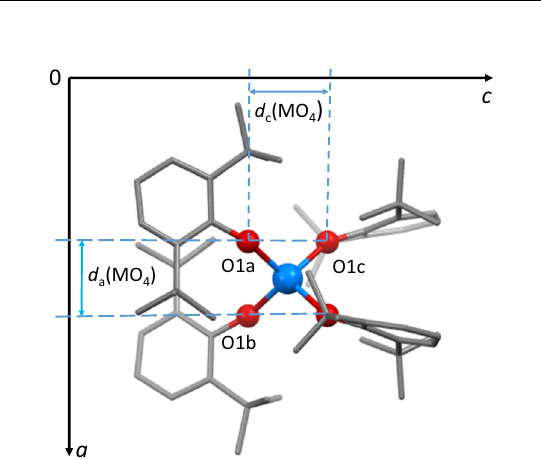
Fig. 2 | The structure of Np(OAr) 4 in the solid state at ambient pressure. Hydrogenatomsandanidenticalmoleculeattheoriginareomittedforclarity.The crystallographicaxesand atomsusedto monitorstructuralchangeswithpressure, and the projections ( d ) along the a and c axes that show the changes in the MO 4 tetrahedron with pressure are indicated.